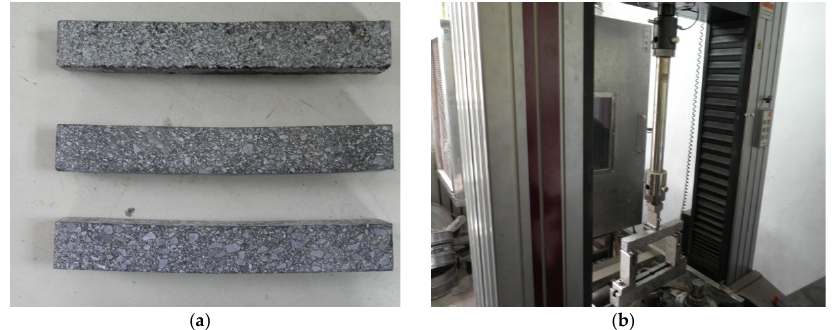
Figure 12. Three specimens ( a ) and Materials Testing System (MTS) ( b ) for low temperature bend test at −10 °C, at loading rate of, 50 mm/min. Table 19. Results of low temperature bend test.